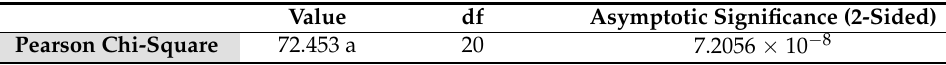
Table 15. Chi-square tests.